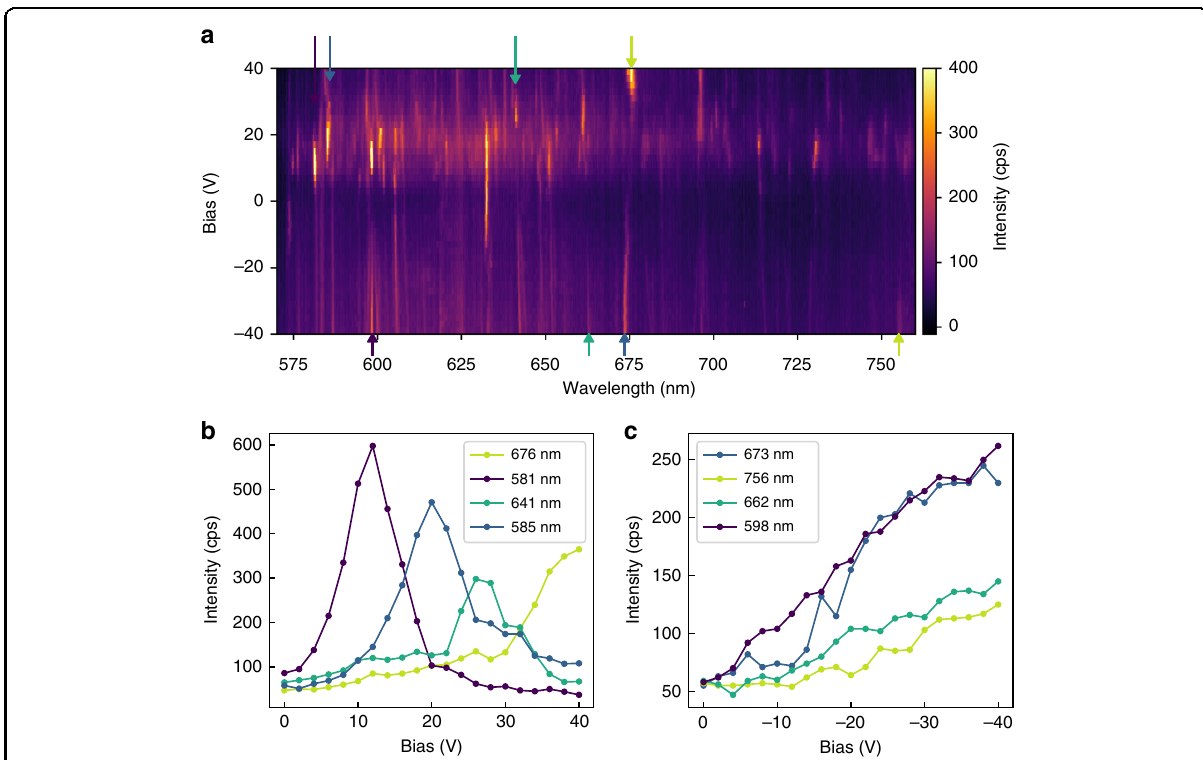
Fig. 3 Activation of hBN emitters in the heterostructure device. a PL spectra recorded as a function of bias, over the range of − 40 to + 40 V. The lines at 580 nm and 620 nm are the G band and 2D band of MLG. The remaining lines are emitters in hBN. The upper and lower arrows indicate the position of the PL lines from which peaks are emission maxima are extracted for ( b ) and ( c ) respectively. b , c Emission intensity versus bias for a number of emitters activated by a positive ( b ) and a negative ( c ) voltage applied to the MLG